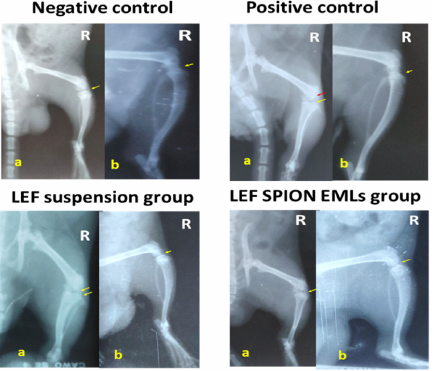
Figure 7. X-ray photographs of the right knee joint of different experimental groups, where ( a ) is the antero-posterior view and ( b ) is the latero-medial